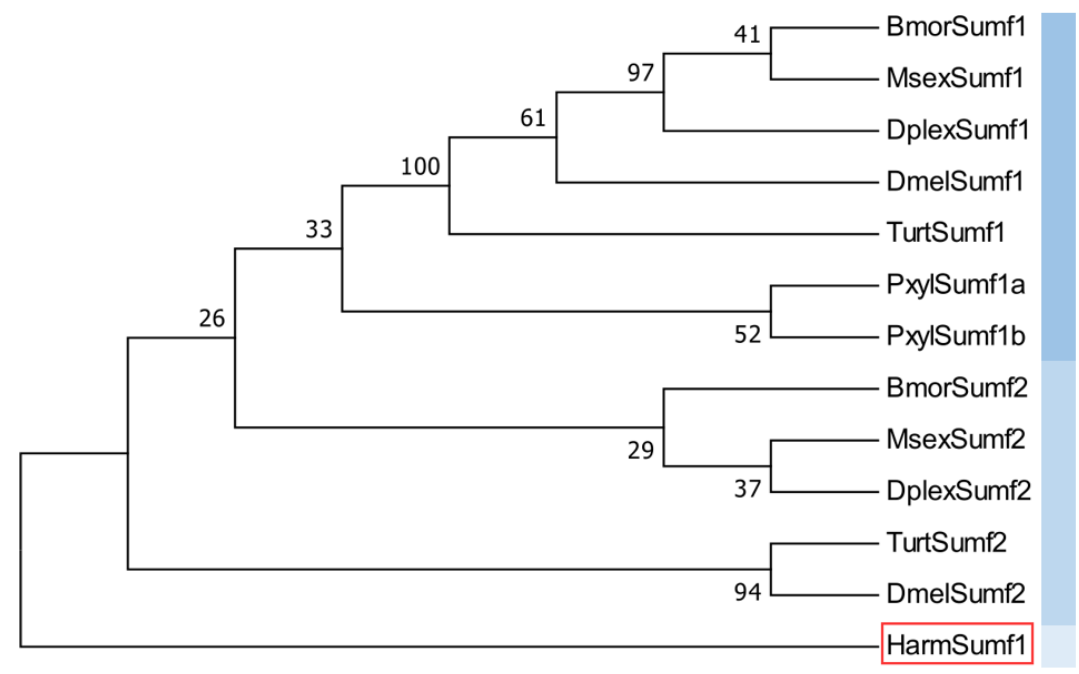
Figure 11. Phylogenetic tree of the amino acid sequence of HaSulf modifying factor (HaSumf1).